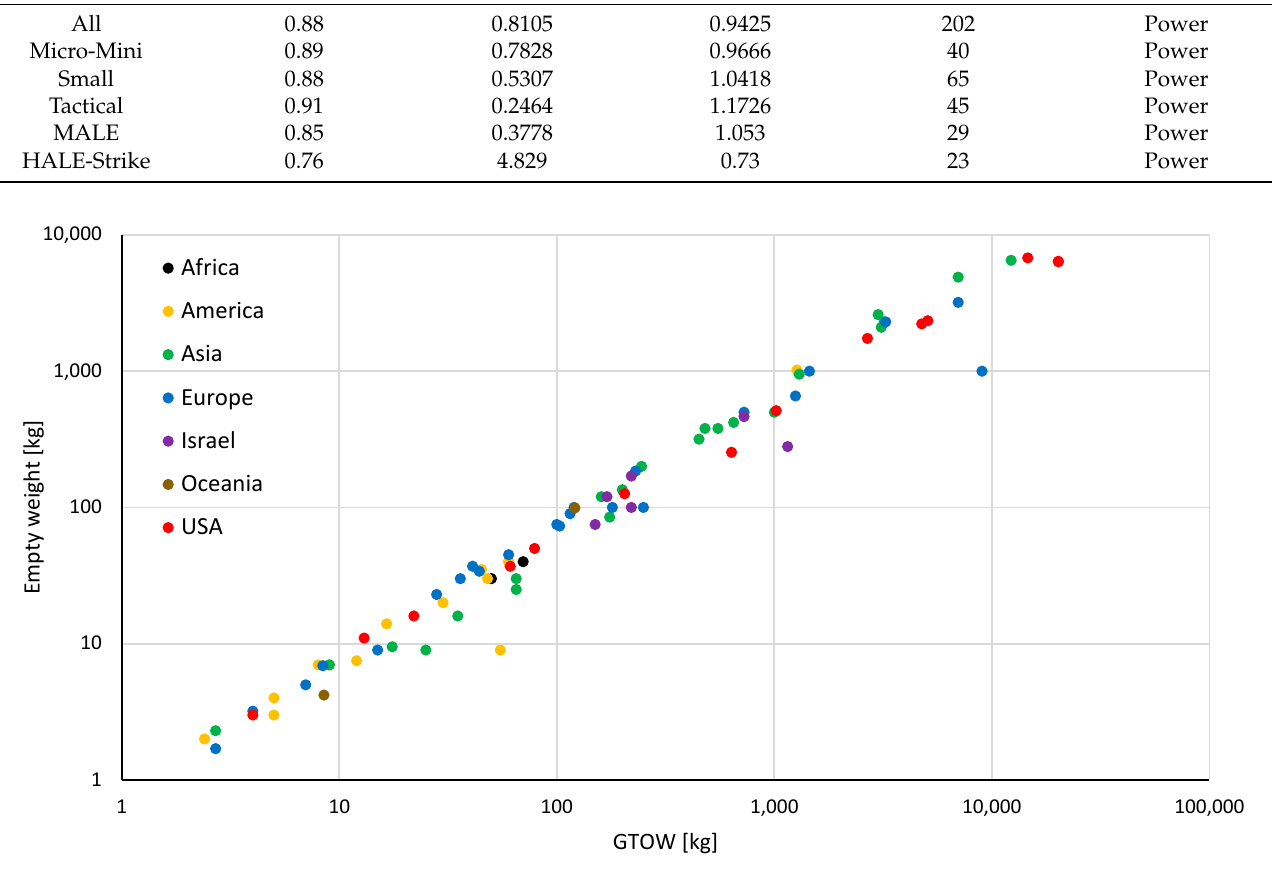
Figure 13. Empty weight as a function of GTOW with respect to region of origin. The next two figures (Figures 14 and 15) are used to present the empty weight ratio as a function of GTOW, for the general category and NATO categorized UAVs, respectively.